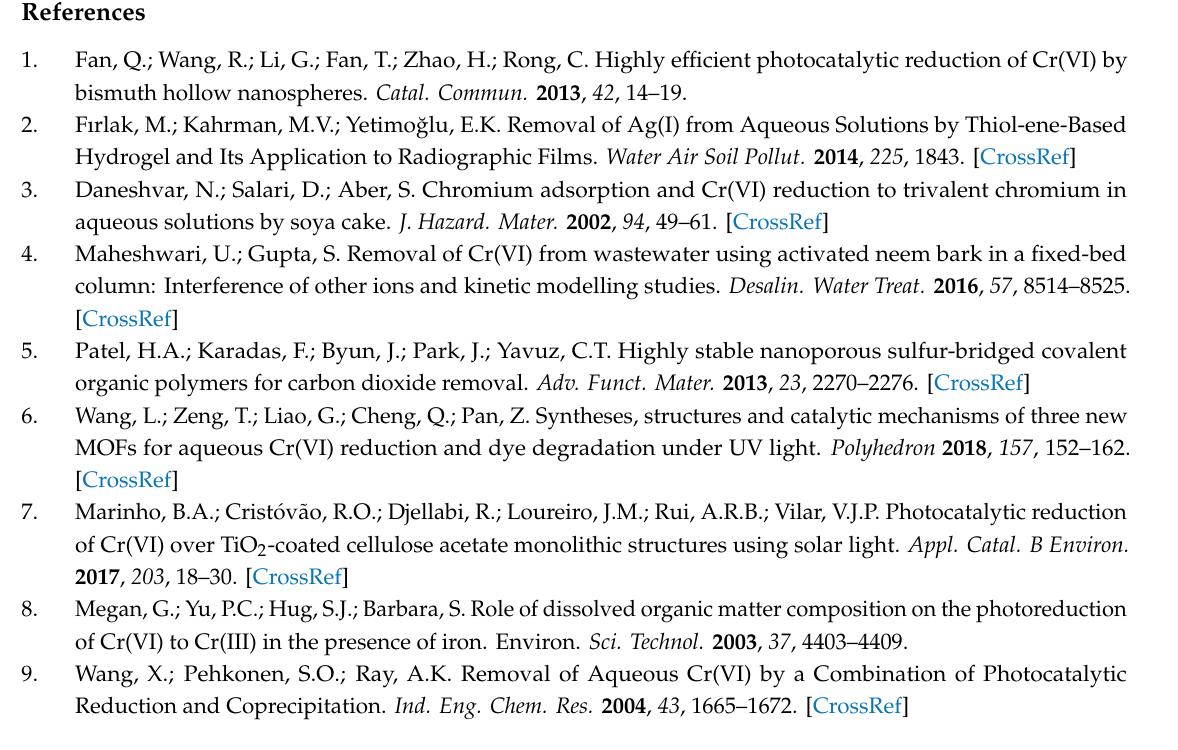
Figure S1: Figure S1. SEM image of Bi 2 S 3 (a), the element composition (b) and elementary mapping of Bi (c) and S (d). Figure S2: Figure S2. SEM image of 5%-ZnO / Bi 2 S 3 (a), the element composition (b) and elementary mapping of Bi (c), S (d), Zn (e) and O